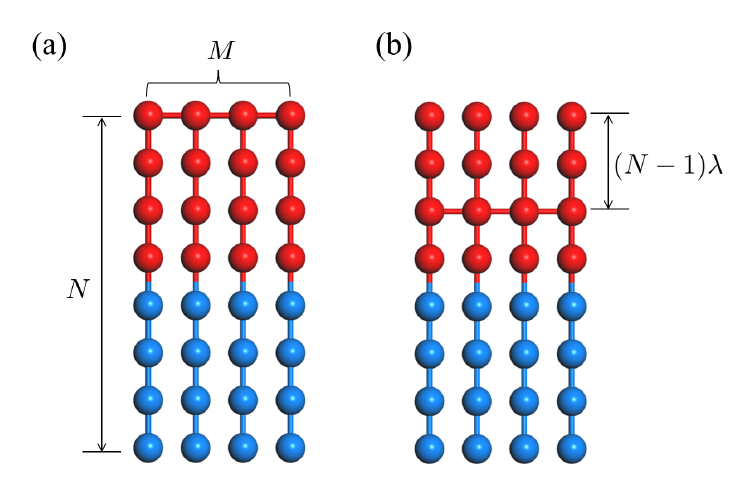
Figure 1. Illustration of polymer architectures consisting of M symmetric diblocks: ( a ) CS-BBC ( λ = 0); and ( b ) its structural isomers ( λ >